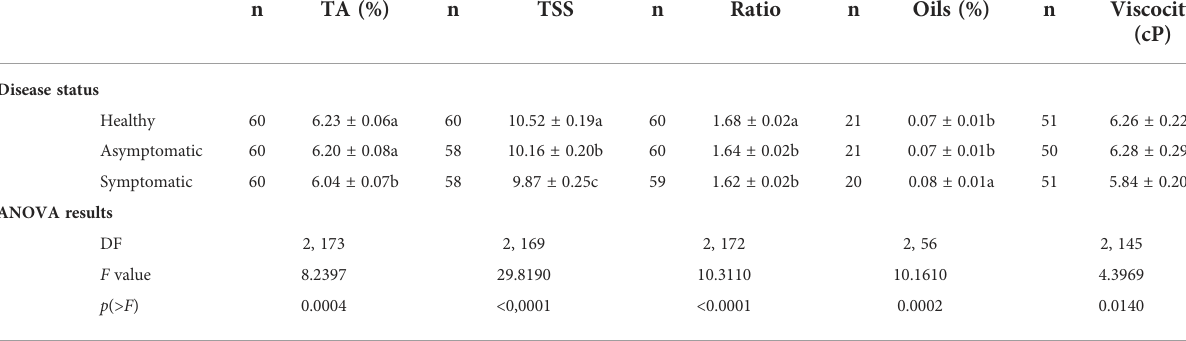
TABLE 5 Industrial quality of extracted ‘ Femminello ’ lemon juice from fruits collected from healthy trees and from the asymptomatic and symptomatic sector of HLB-affected trees (diseased trees) collected in different harvesting seasons in the south-southeast of São Paulo State xyz . n TA (%) n